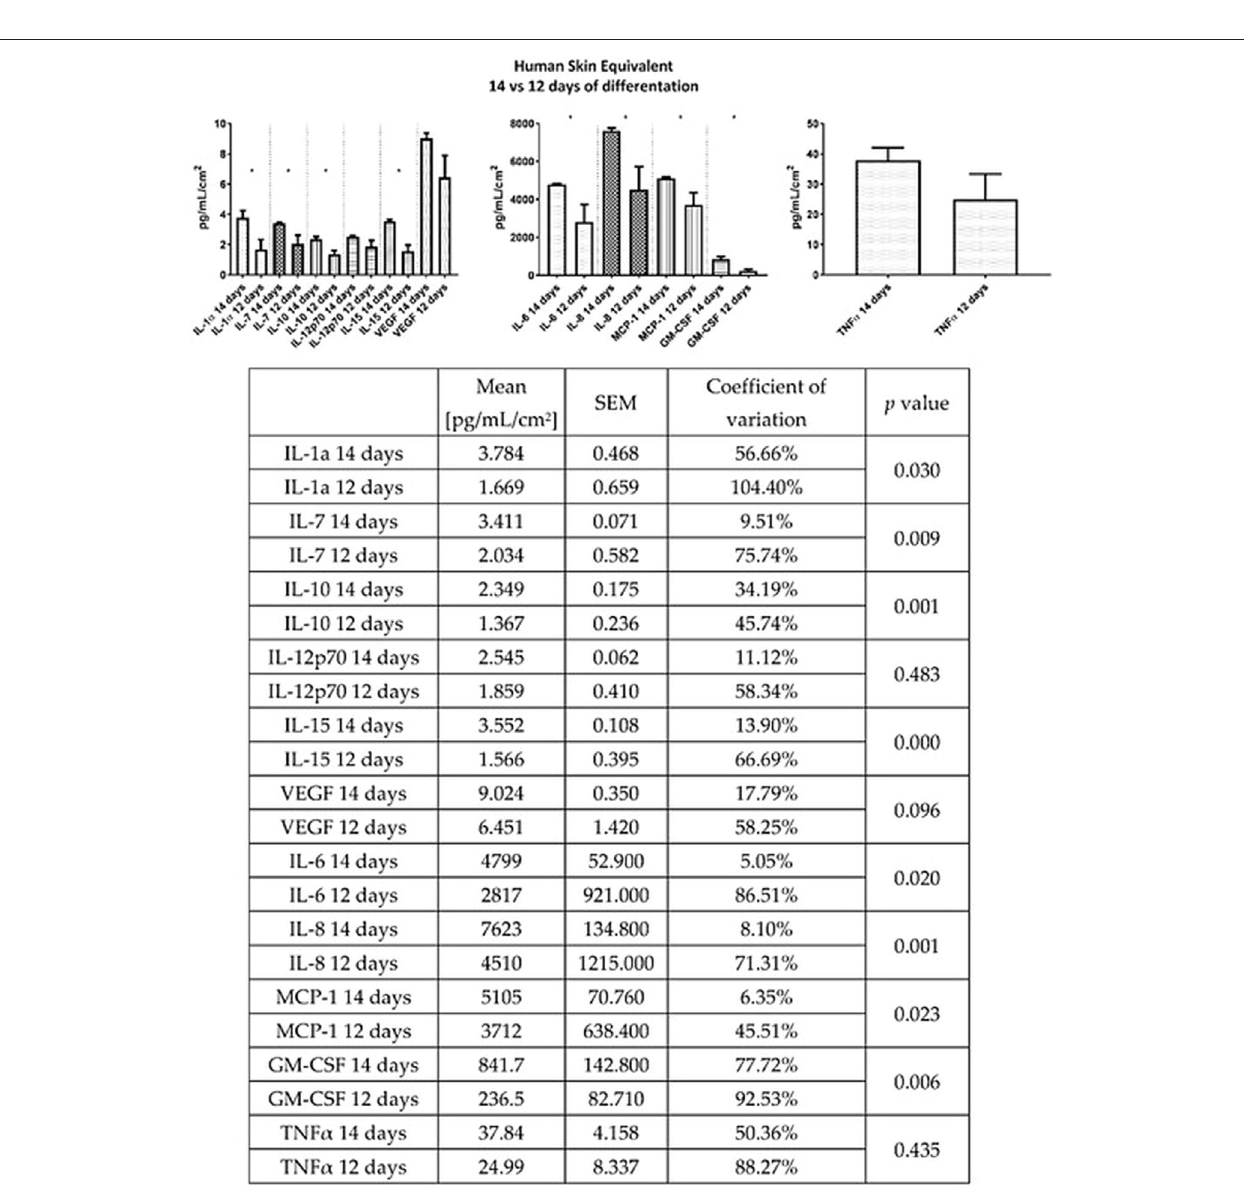
Frontiers in Bioengineering and Biotechnology |